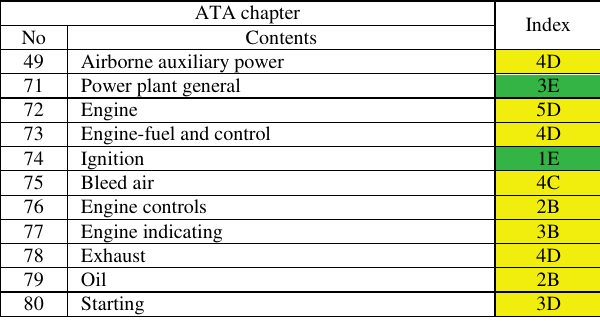
Table 16. Safety risk assessment matrix for jet engine systems